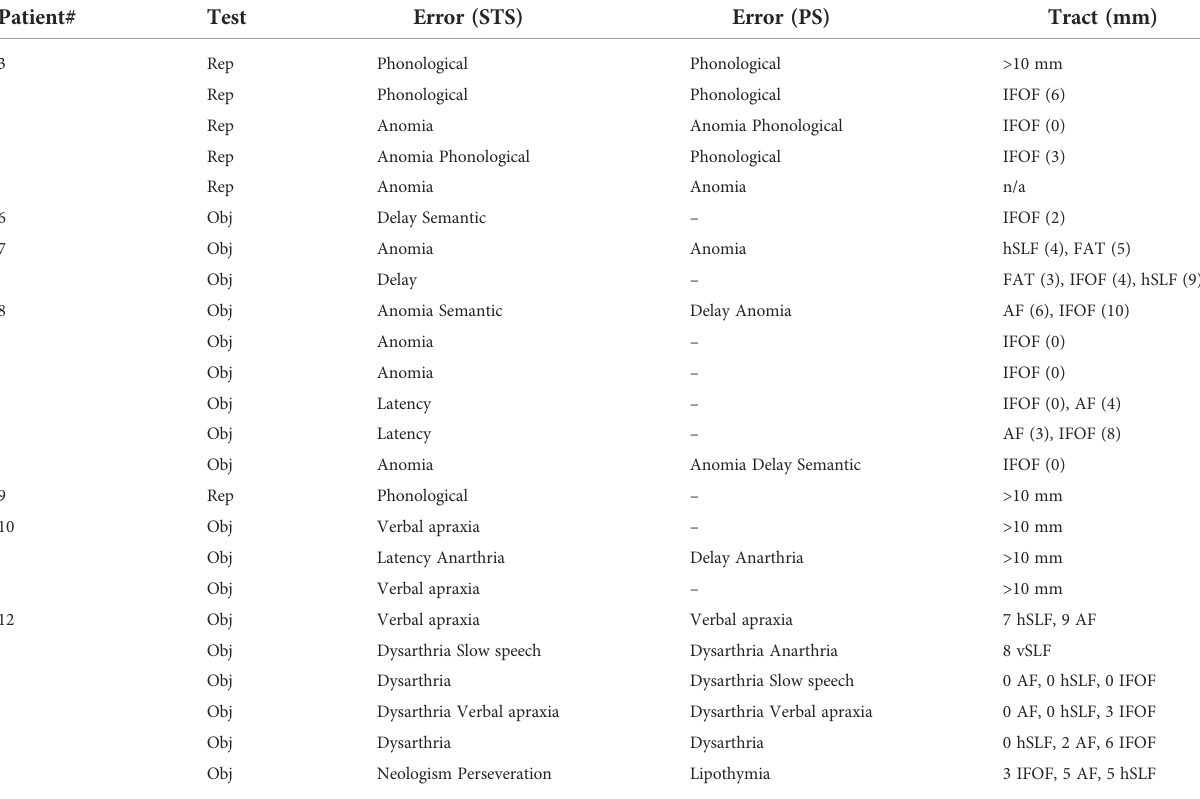
TABLE 3 Language interference and probe distance to language